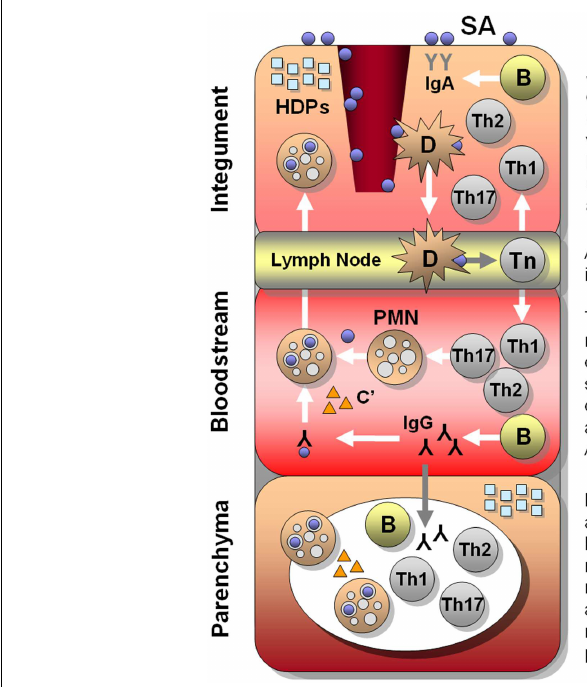
immunological compartment. However, specific profiles and roles of immune effectors may not be identical in each compartment.Vaccines that apply convergent immunity may be designed to optimize those defenses against S. aureus that best protect the host in context of specific